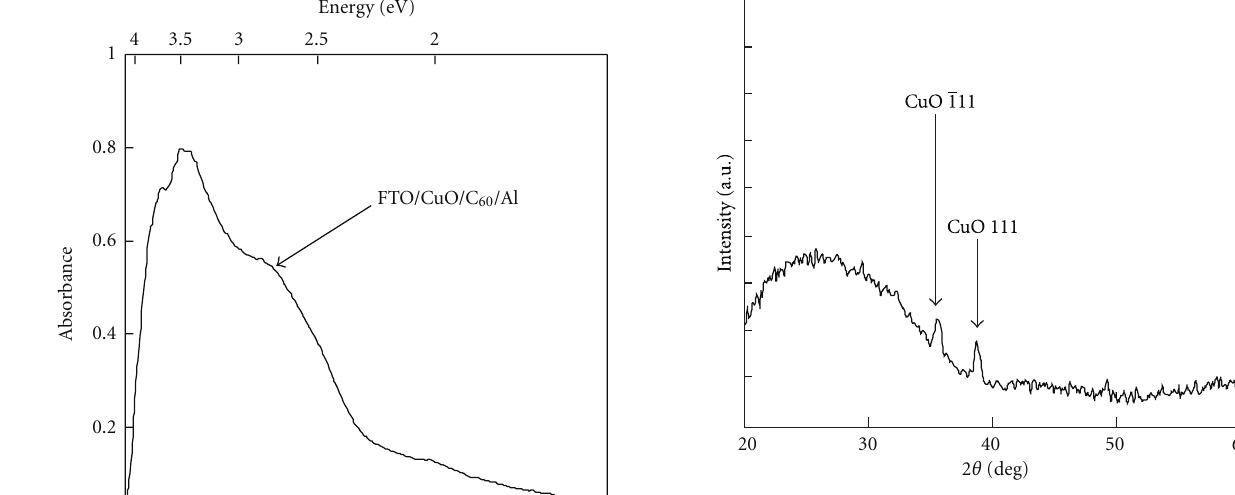
Table 1. A solar cell with a Cu 2 O:C 60 structure provided